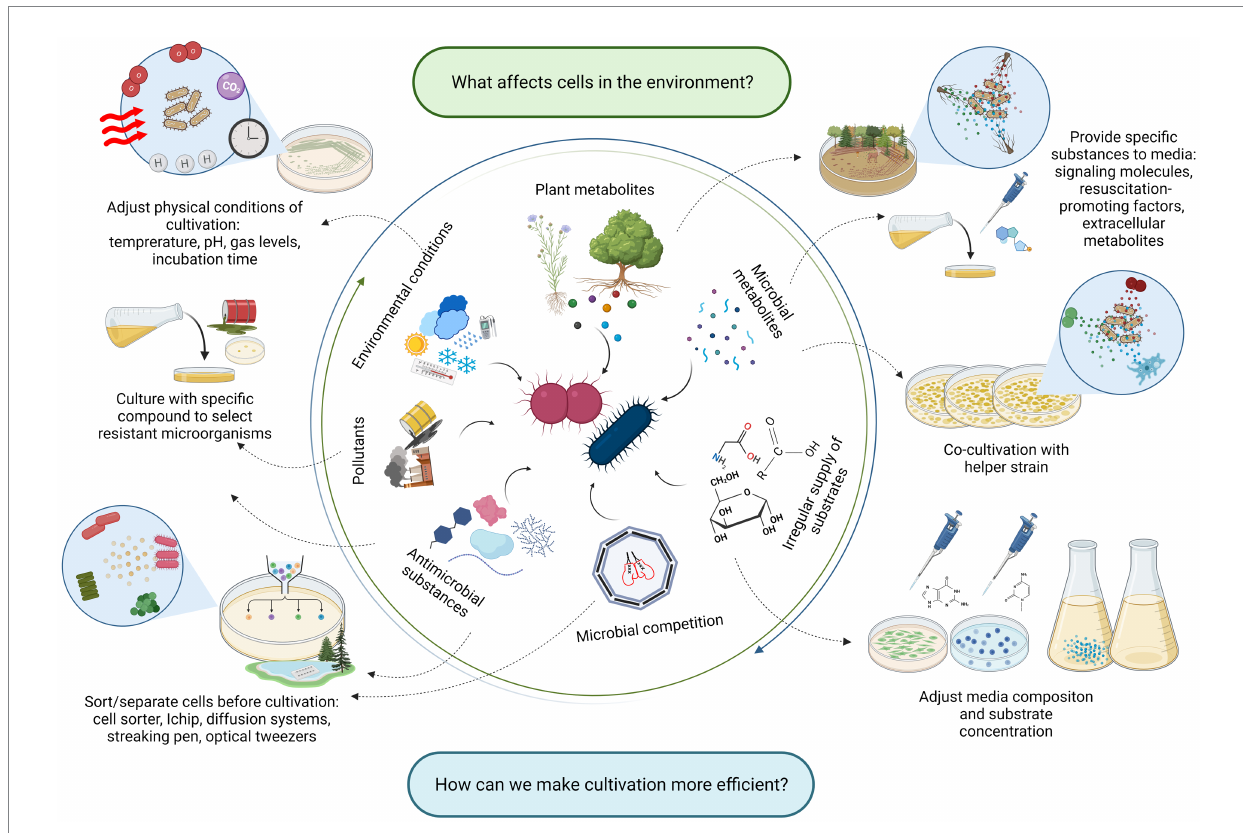
FIGURE 2 The list of factors affecting microorganisms in their environment (inner circle), and strategic approaches reflecting these factors in the cultivation (outer circle). Created with